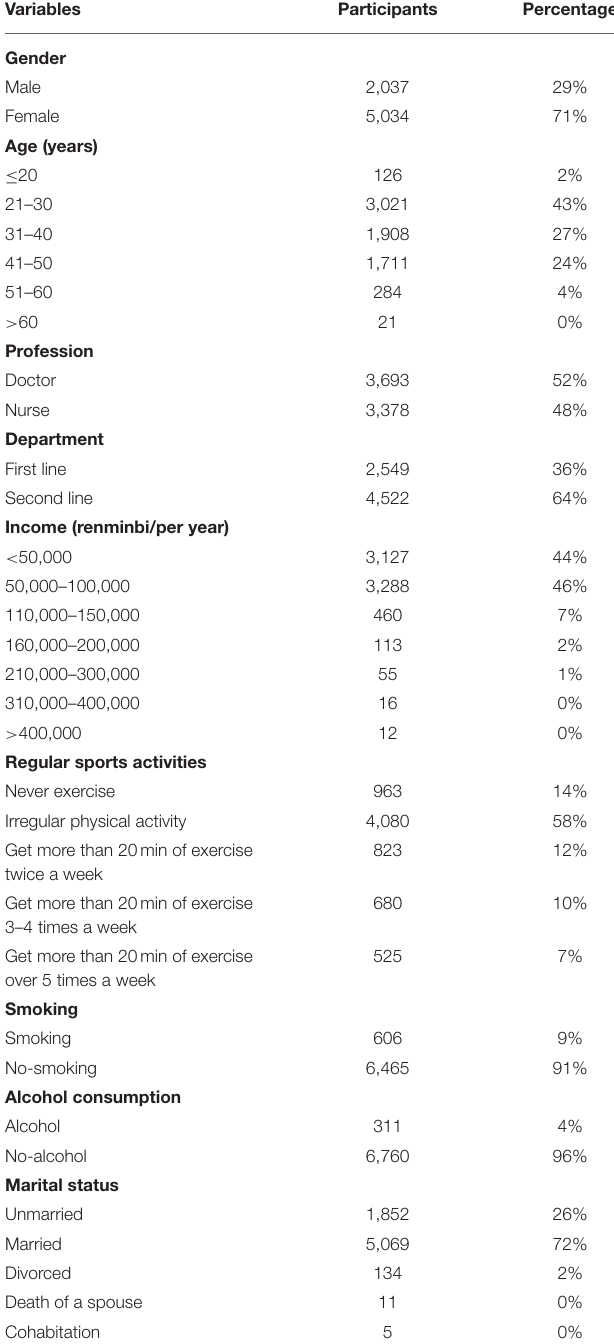
TABLE 1 | Demographic characteristics of the